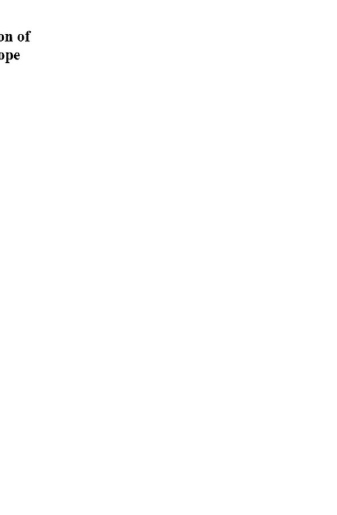
Fig 3. Dam deformation monitoring principle for height with total